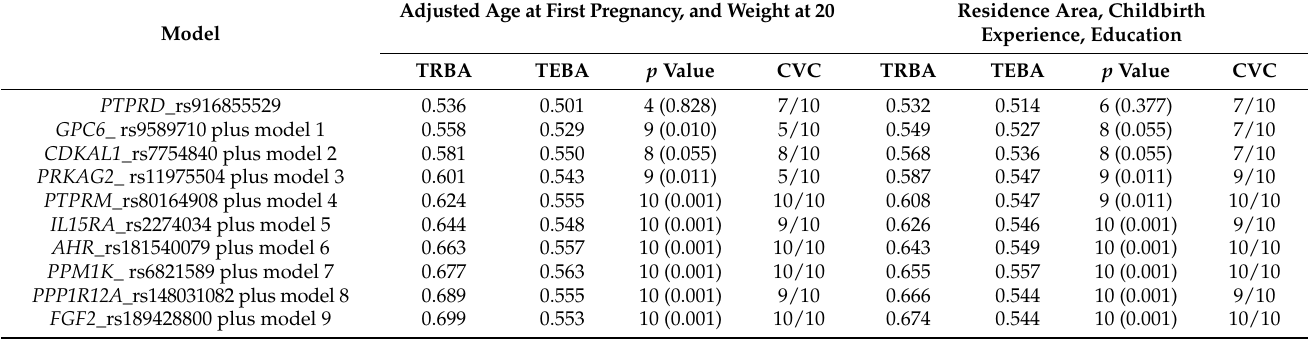
models, respectively. Table 3 lists the other SNP models. Table 4. Generalized multifactor dimensionality reduction (GMDR) results of multi-locus interaction with genes related to gestational diabetes mellitus. Adjusted Age at First Pregnancy, and Weight at Model